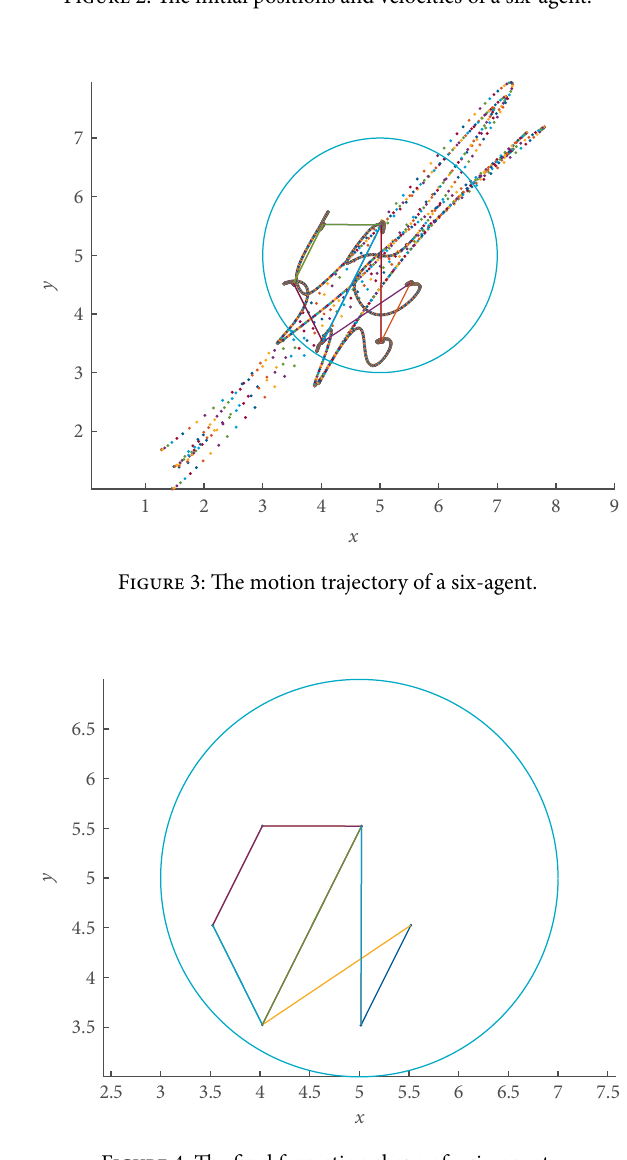
Figure 4: The final formation shape of